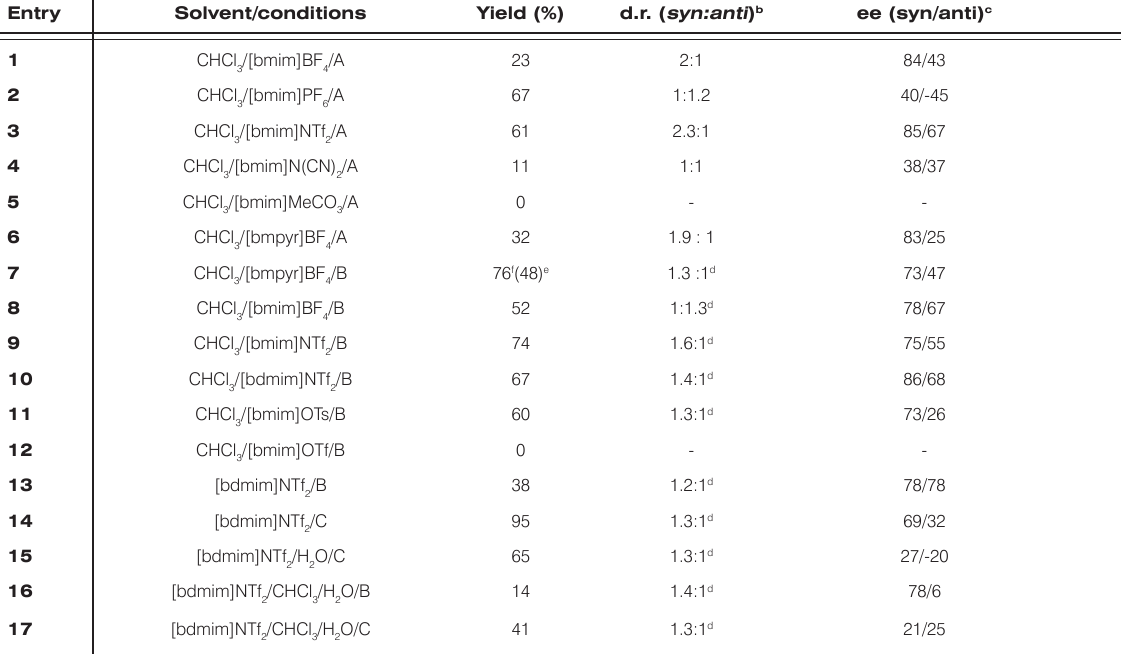
Table 2. Addition of aldehyde 5 to nitroalkene 6 catalyzed by C1 in ionic liquids a .